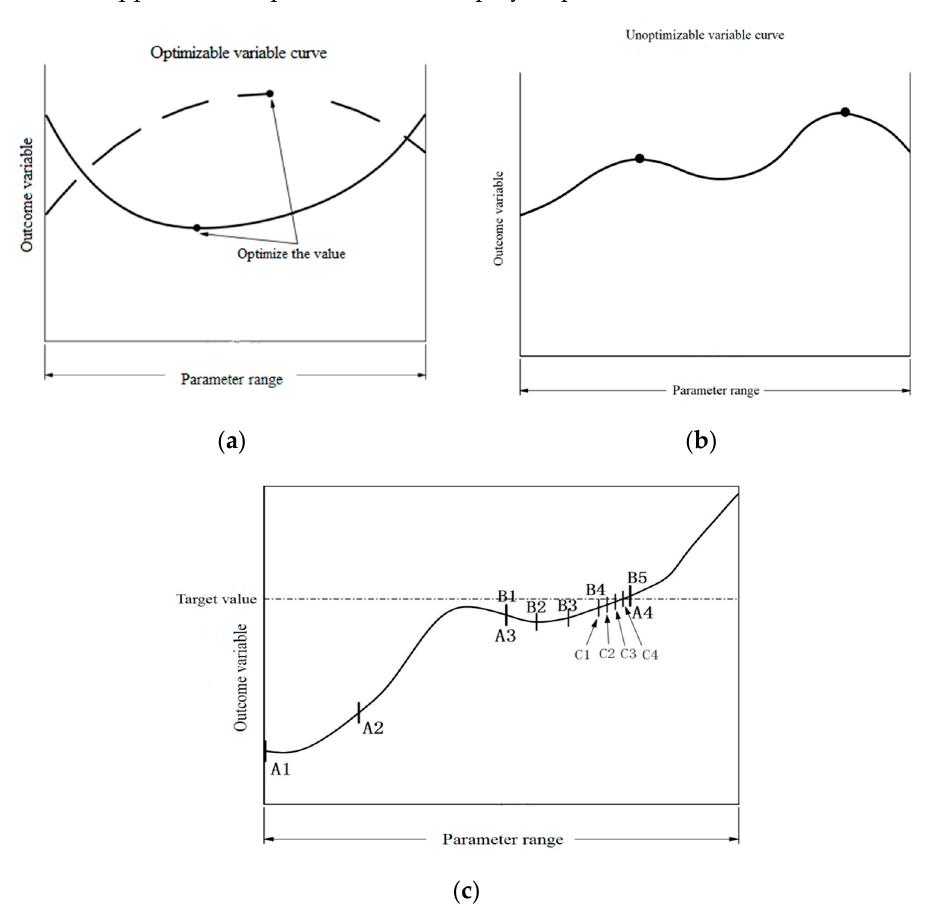
Figure 2. Function mode between RLT variable and design variable of optimization objective function. ( a ) Optimizable variable curve. ( b ) Nonoptimizable variable curve. ( c ) Full range variable curve.